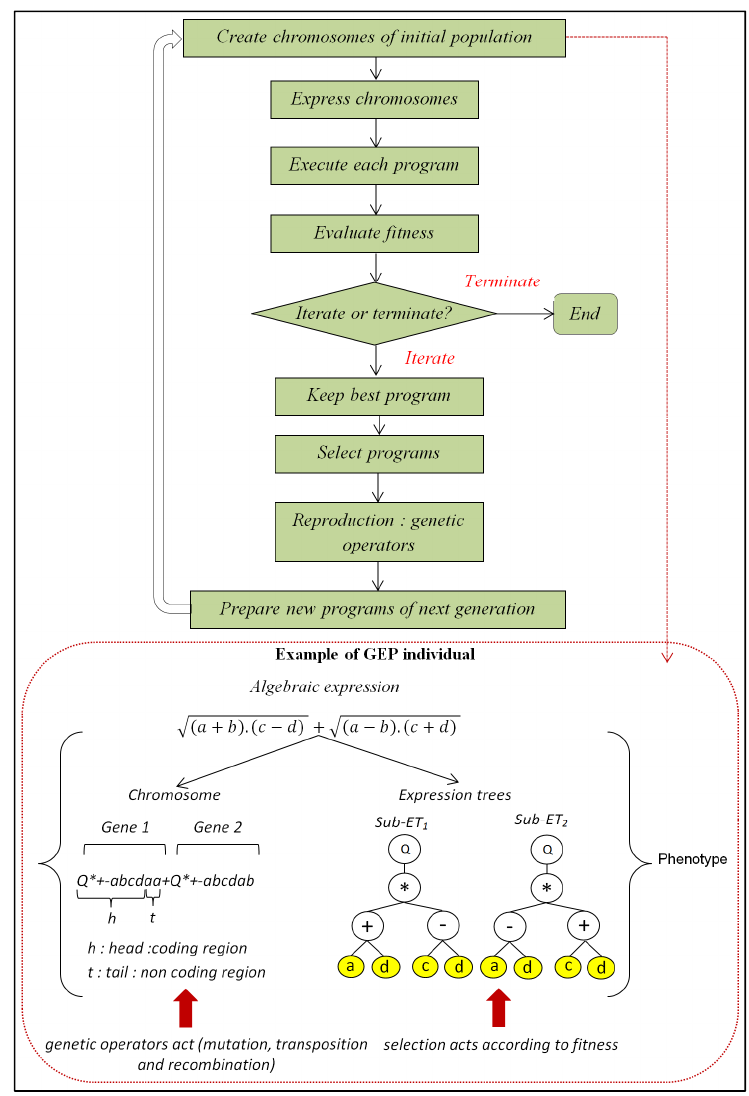
Figure 4. General GEP model implementation and general structure [35].